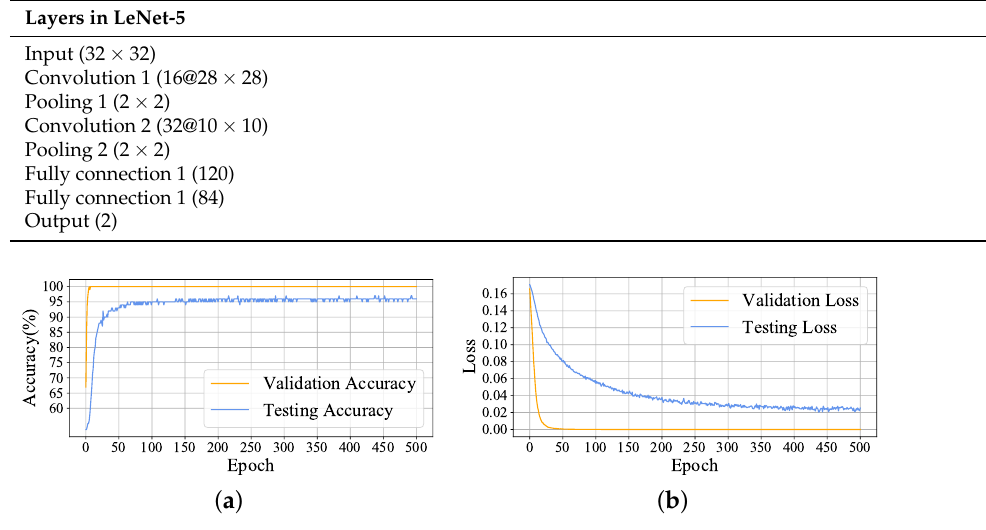
Figure 13. Fault detection experiment result: ( a ) validation accuracy and testing accuracy; ( b ) validation loss and testing